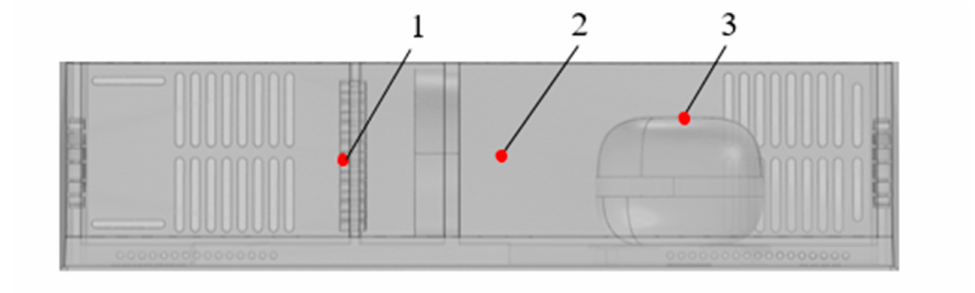
Figure 2. The positions of T-type thermocouples installed in the compressor